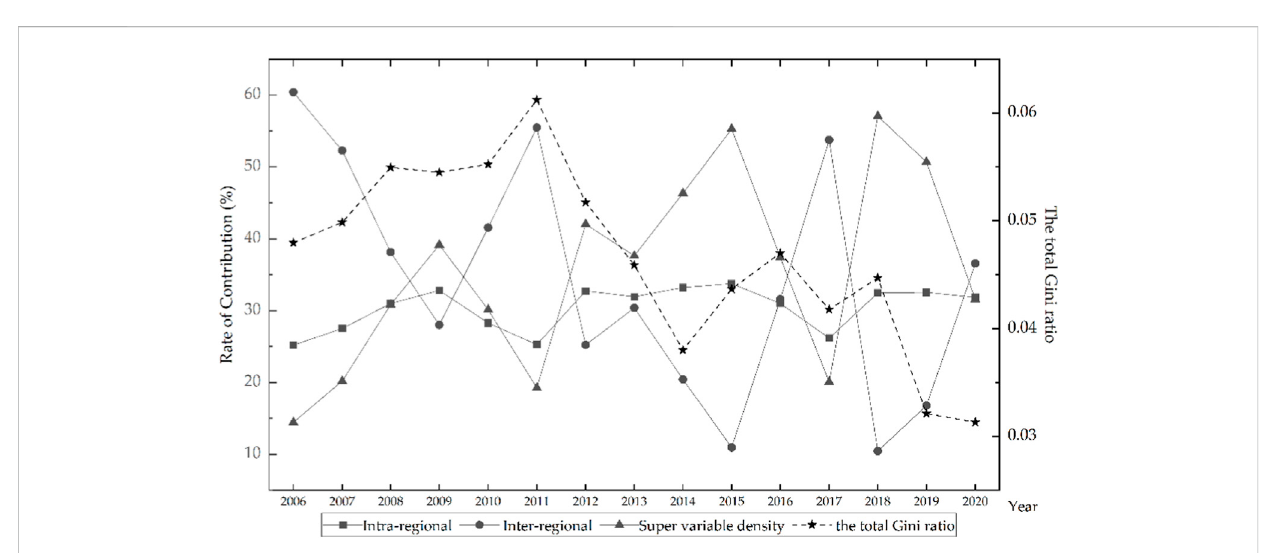
FIGURE 2 Overall difference and contribution rate of green development quality in the construction